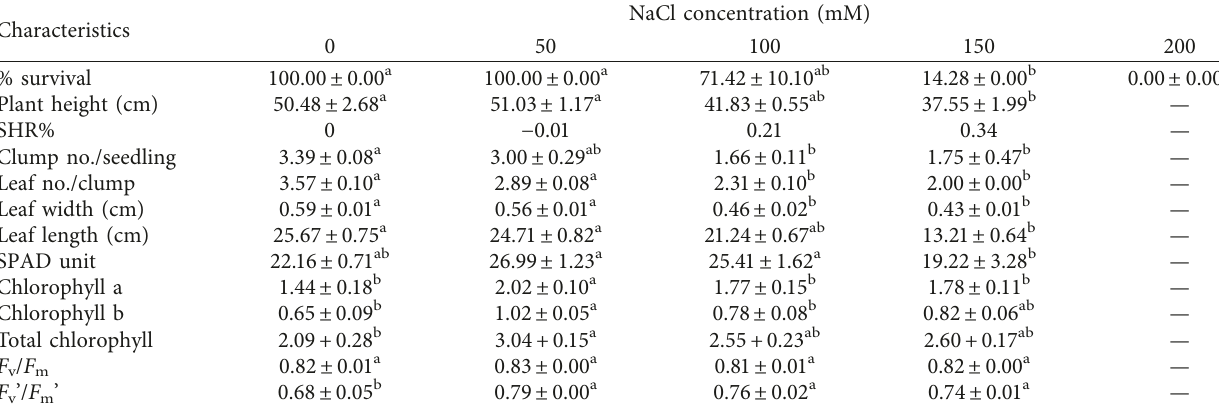
Table 4: Growth and physiological traits of Luem Pua rice seedling after salinity treatment for four weeks. Characteristics